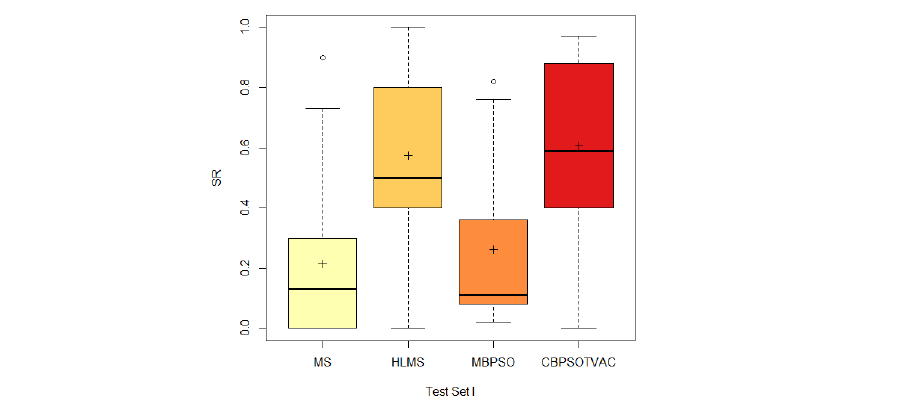
Figure 2. Boxplot for 4 comparative algorithms on SR for Test set I. Table 3. The results of HLMS with 6 comparative algorithms for Test set II.